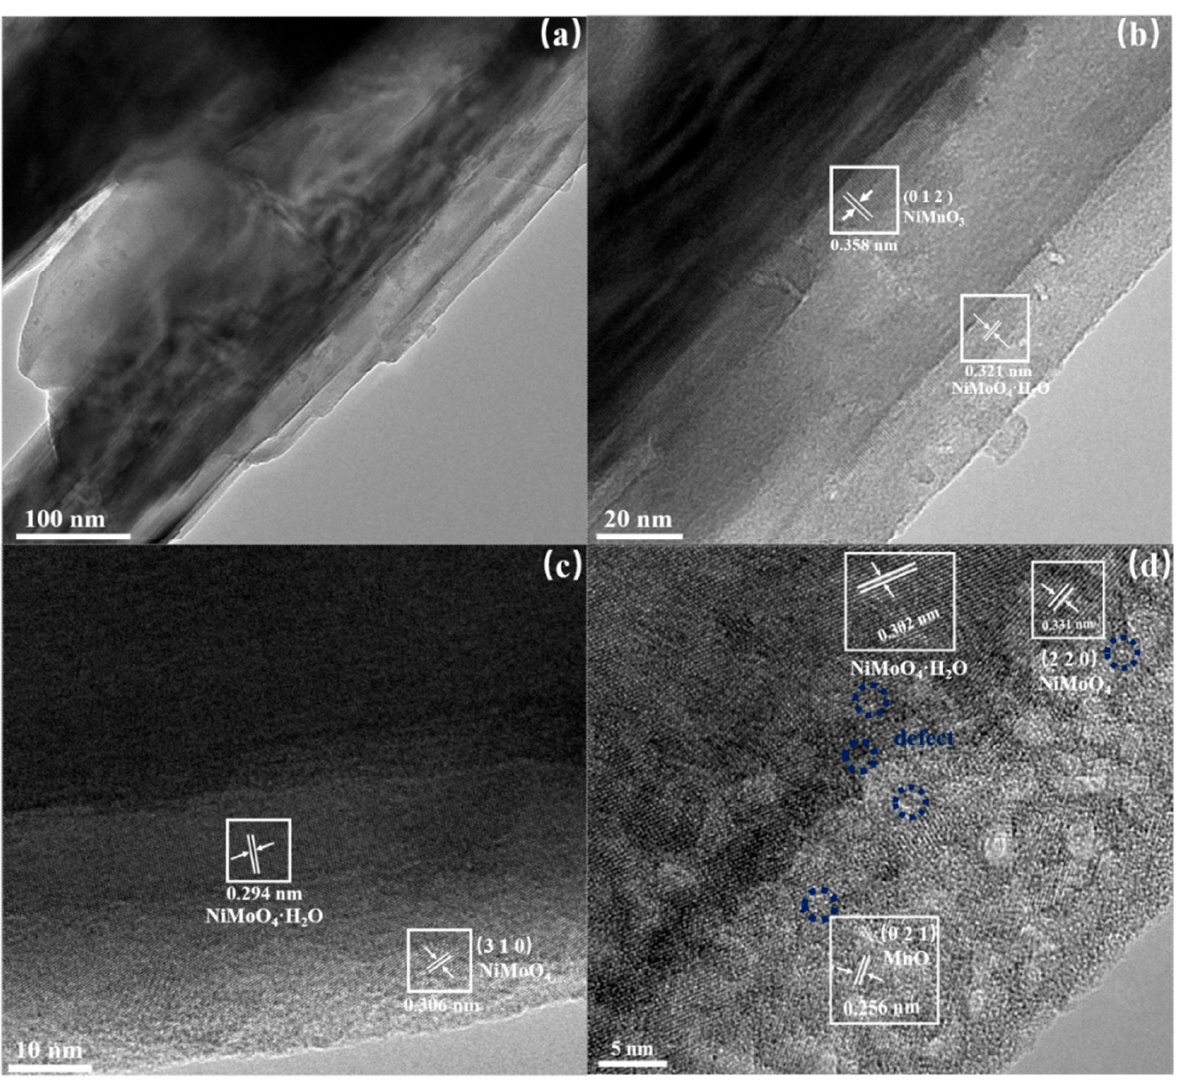
Figure 5. TEM images of ( a – d ) the Mn-doped-NiMoO 4 /NF (25).